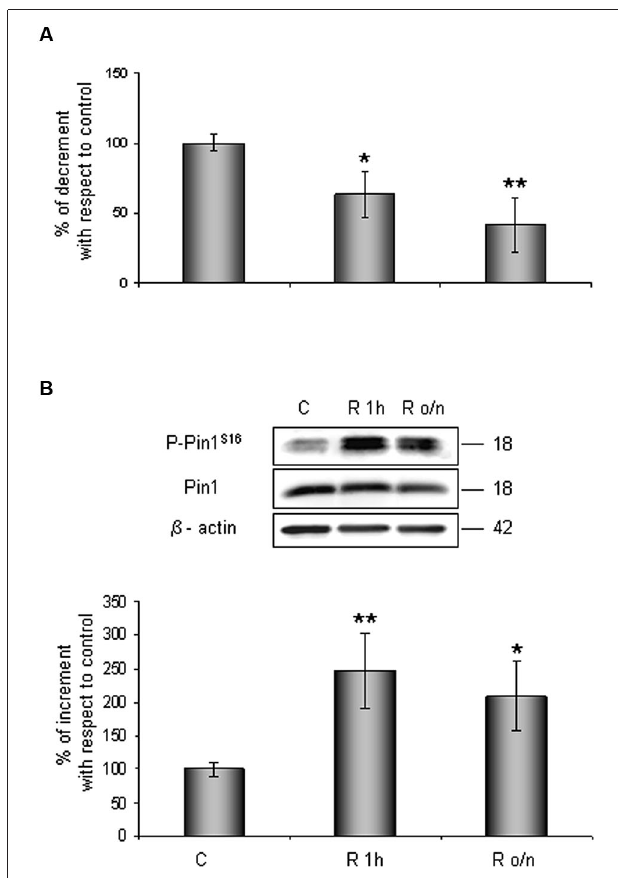
FIGURE 2 | Pin1 inhibition in post-OGD conditions . (A) PPIase activity decreases during restoration of normal cultures conditions following OGD. Cells were lysed and collected in non denaturising NP40 buffer at R 1 h and R o/n. Pin1 isomerase activity against Ac-AA(pS)PR-pNA substrate were measured as described in materials and methods. The measured activity was normalized to the total protein concentration of the lysate. (B) Pin1 S16 phosphorylation increases in response to OGD treatment. Cells were lysed in the presence of 2% SDS lysis buffer after OGD treatment and restoration of normoxic and glucidic conditions for different times (R 1 h, R o/n). Total protein content were subjected to SDS-PAGE and Western blot analysis. P-Pin1 S16 and total Pin1 were detected by specific antibodies and revealed by ECL, and semi-quantitatively determined by a KODAK image station 2000R. Anti- β -actin antibody was employed to confirm equal protein loading in the different lanes. Results obtained are shown on the bar-graphs. The amount of P-Pin1 S16 correspond to phospho-protein level on Pin1 total protein. Normalization was carried out with respect to the β -actin amount in the same sample. Data represent the mean ± SEM of three separate experiments performed in triplicate. Statistical significance is obtained with Student’s t -test in comparison with controls. * p < 0.05, ** p < 0.01.